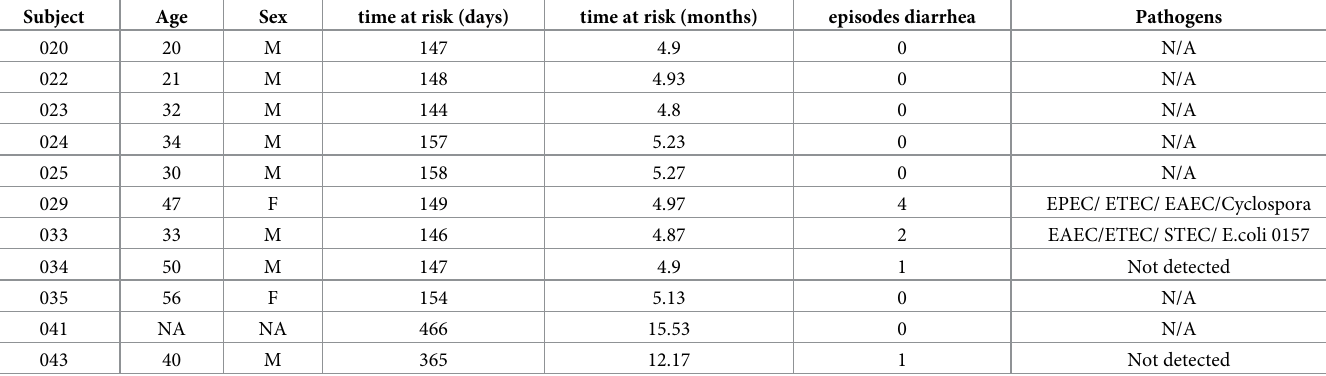
Table 8. Nested cohort (Study 2b), demographics and summary of diarrheal incidents and clinical